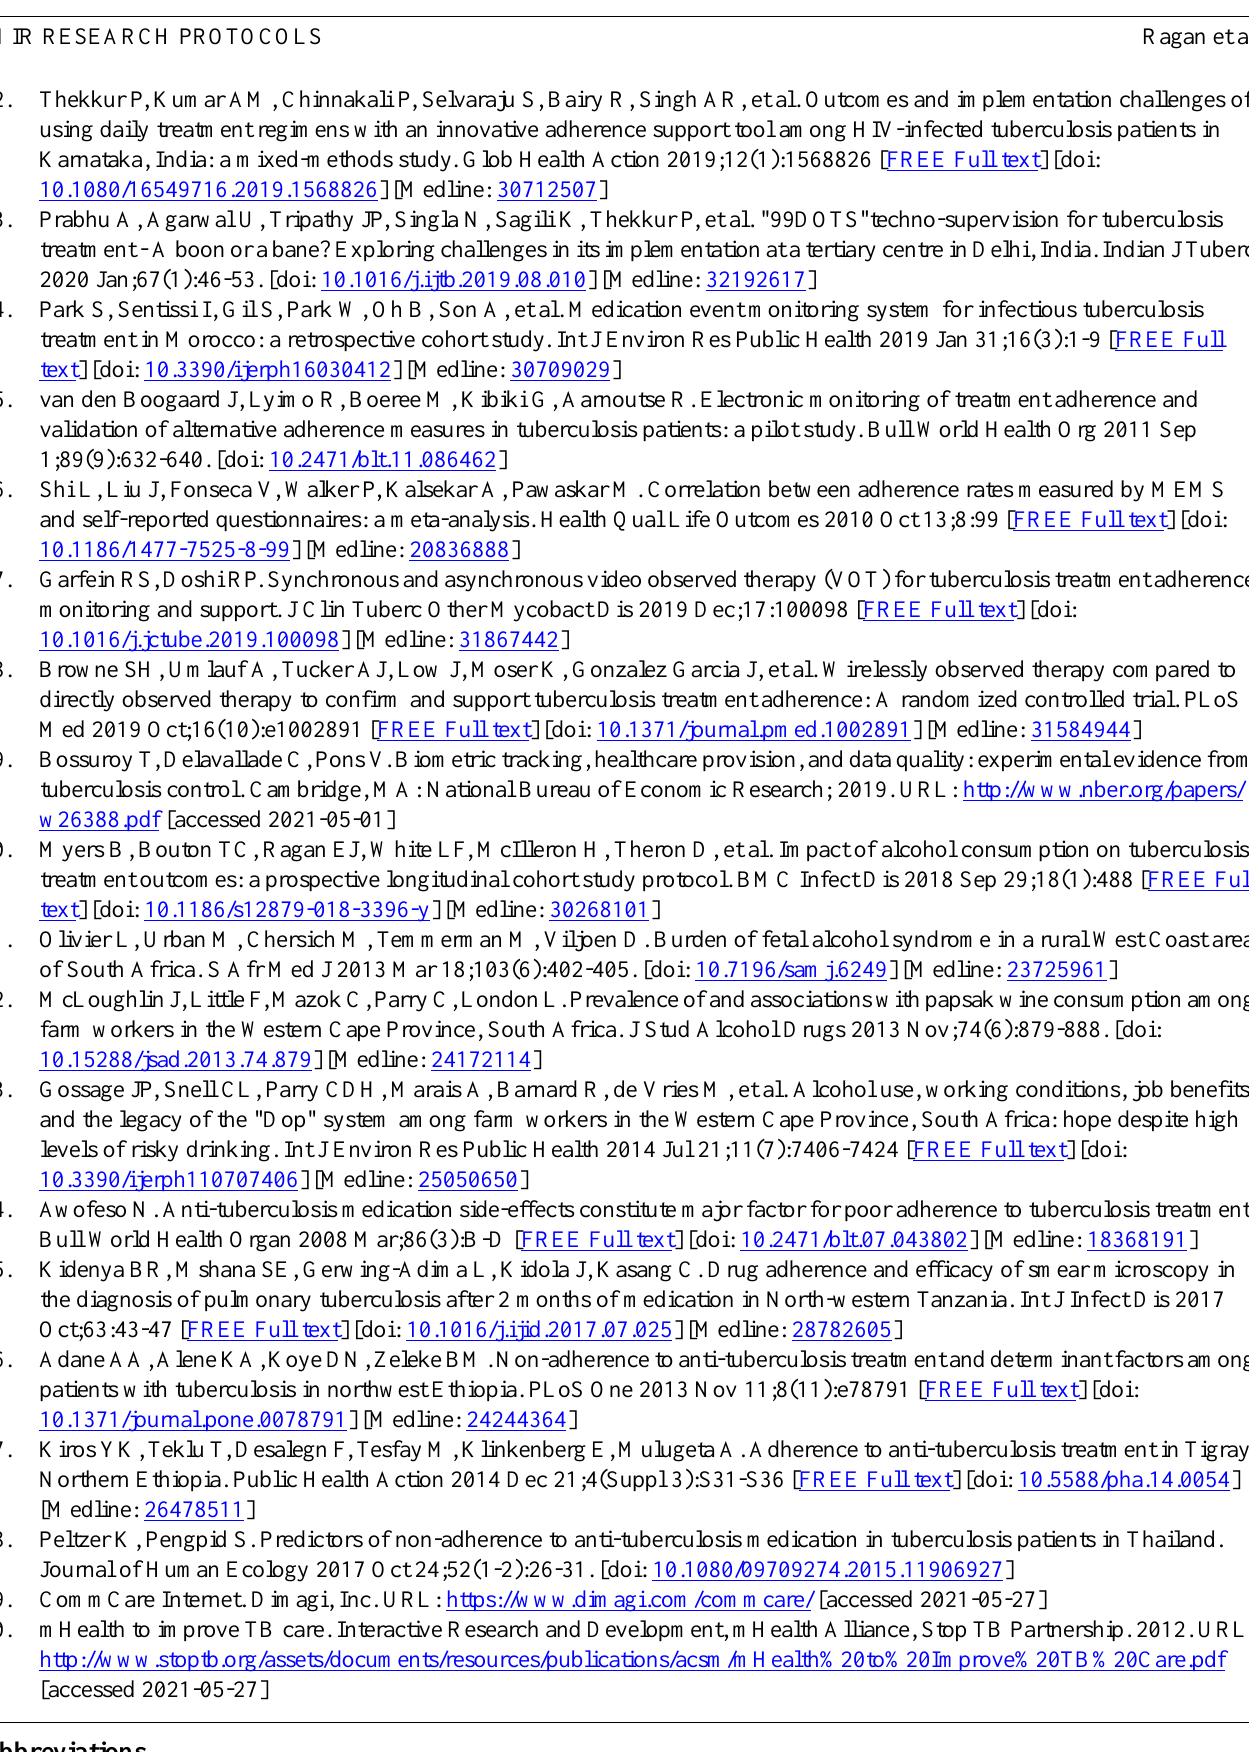
Abbreviations DOT: directly observed therapy DOTS: directly observed therapy, short-course